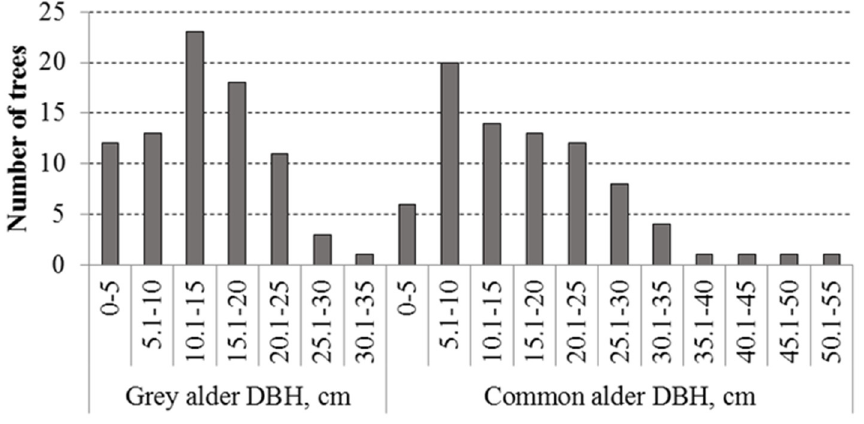
Figure 1. Distribution of sample trees into diameter